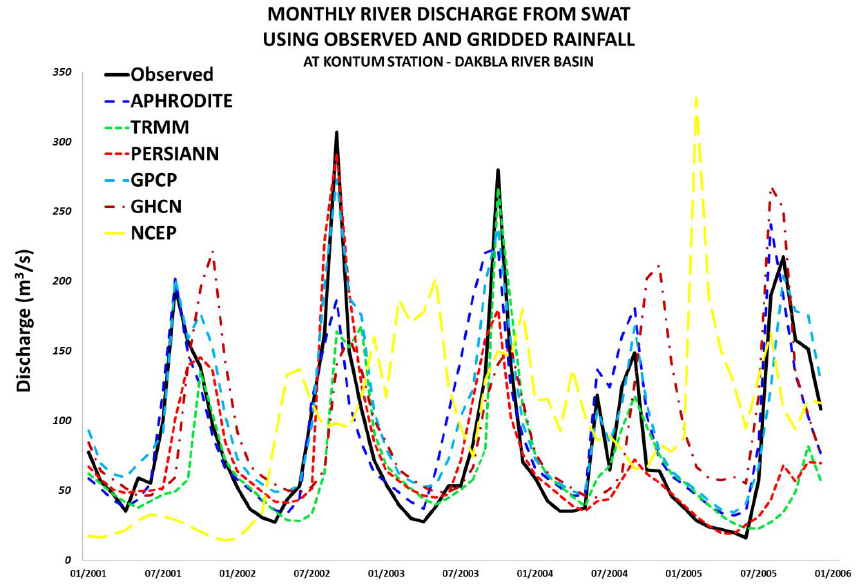
Fig. 5. Application of station, gridded observations and Reanalysis data to stream flow discharge over Dak Bla river, monthly aggregated from daily data.